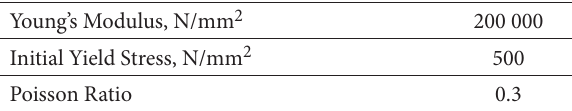
Table 3. The basic material characteristics of material model “steel